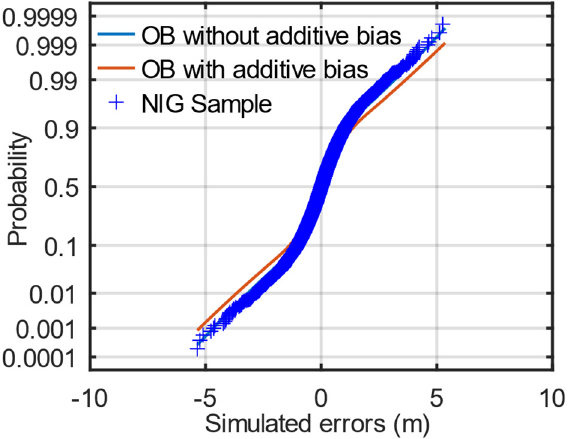
Figure 4. NIG samples and overbounds with and without additive bias. These are plotted as CDFs with the y -axis scaled to better show the tails. OB is an abbreviation for “overbound“.